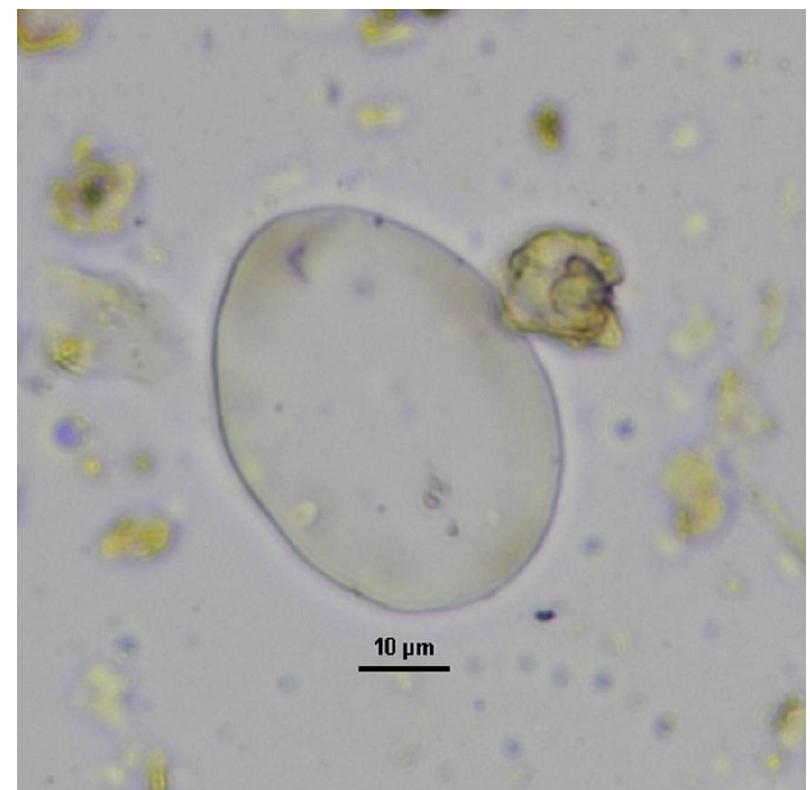
Figure 10. Recovered starch grain in polarized light. Artefact 5, point sample 1, at 400x.